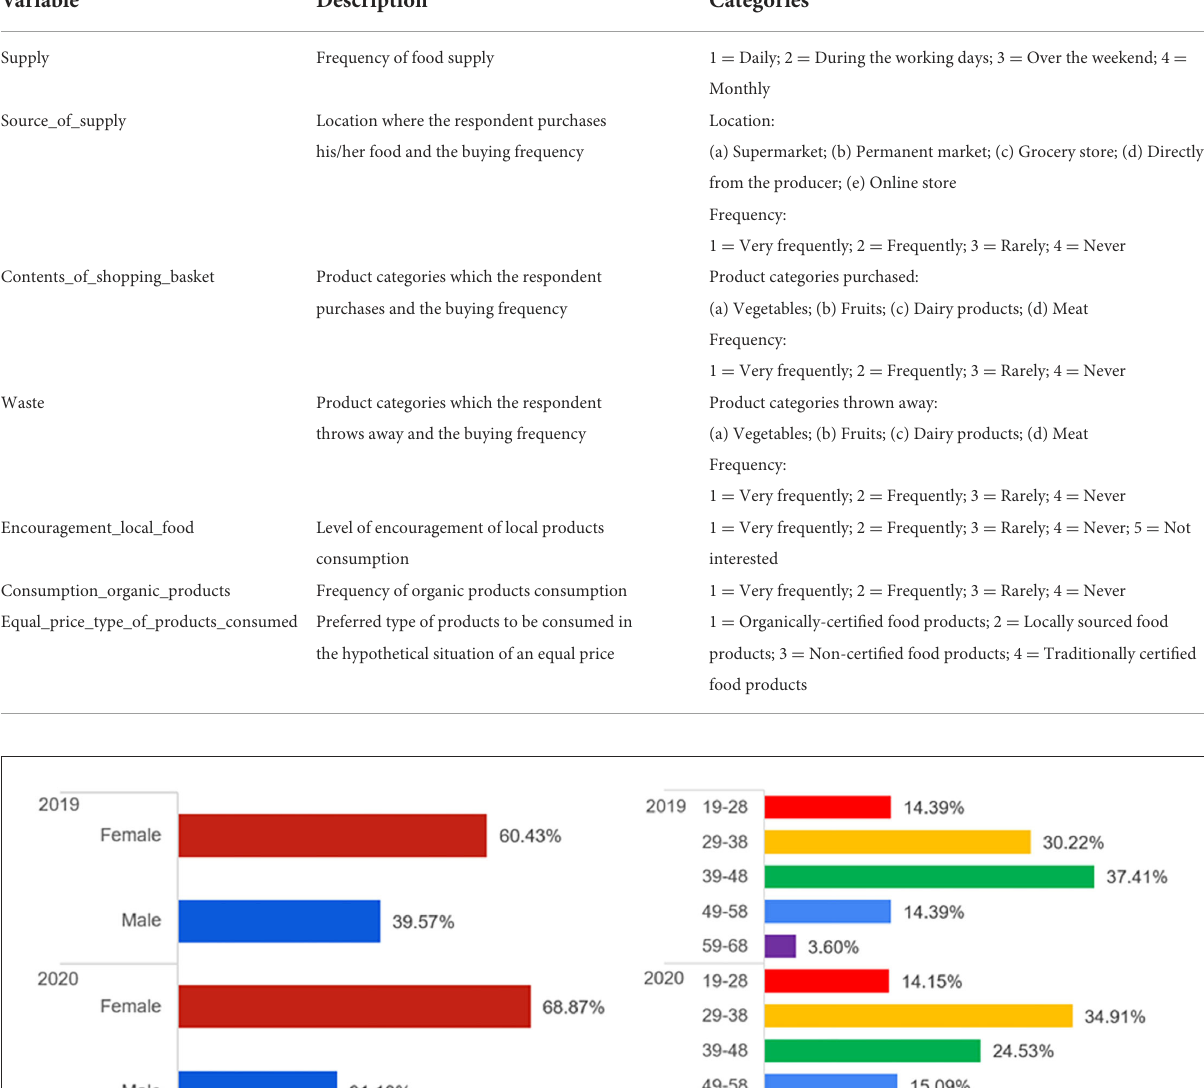
TABLE 1 Description of variables.